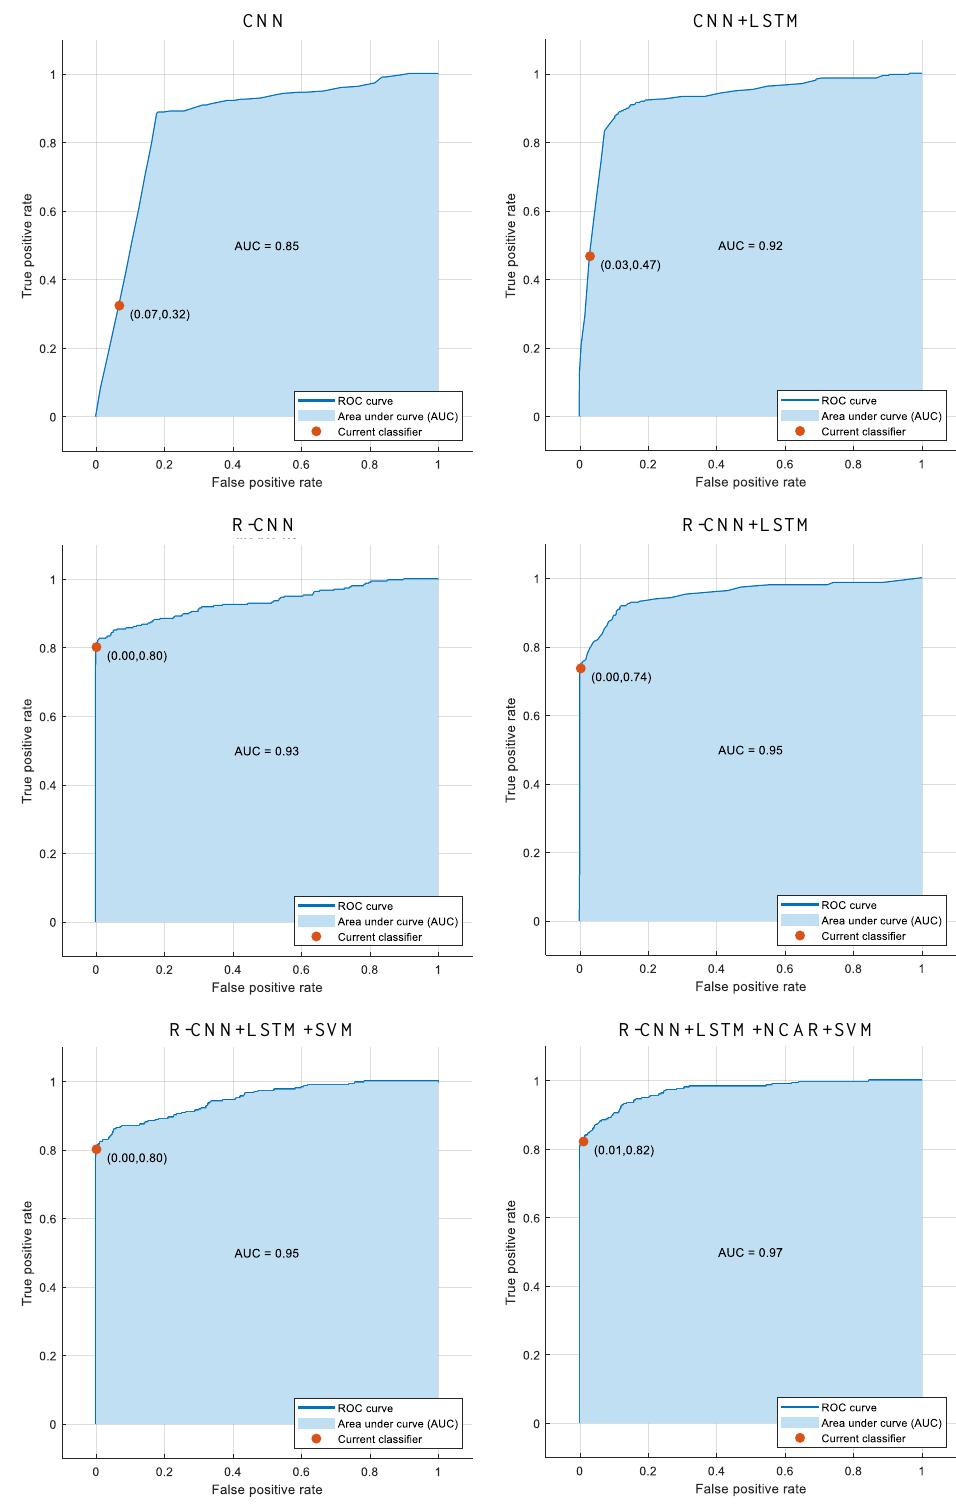
Figure 10. The ROC curves and AUC values for six different approaches.